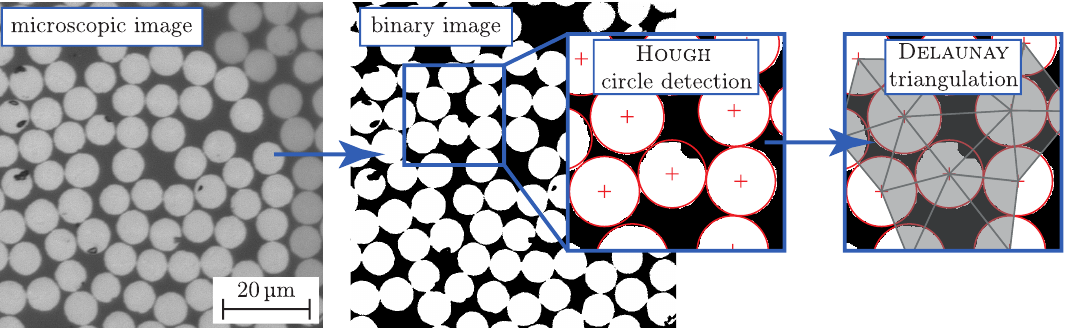
Figure 10. Schematic illustration of the proposed algorithm determining the microscopic FVC φ ( m ) .